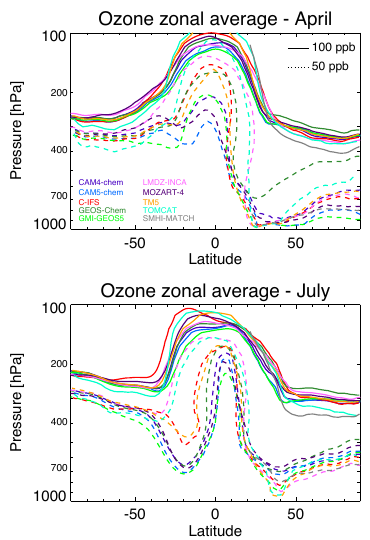
Figure 5. Location of the 50 and 100ppb contours of O 3 for the zonal averages of each model in April and July.